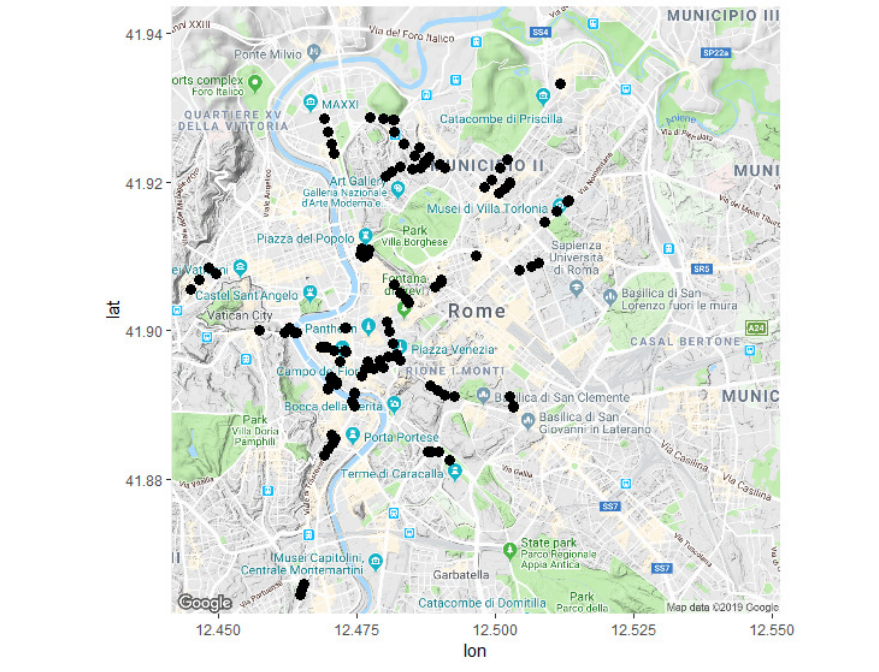
Figure 4. Taxis trajectories in